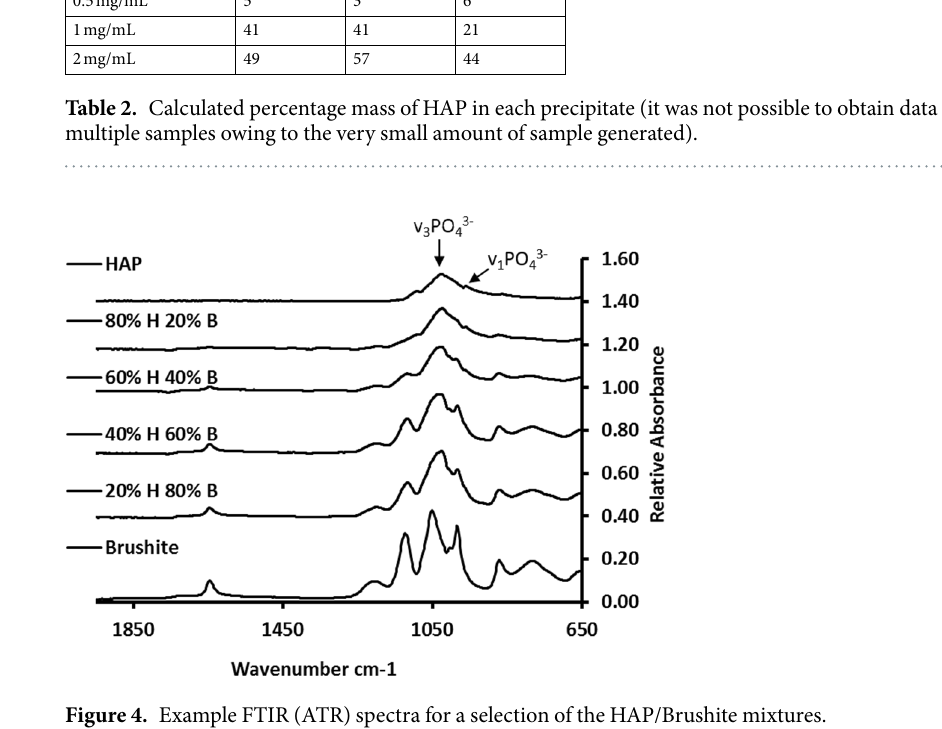
Figure 4. Example FTIR (ATR) spectra for a selection of the HAP/Brushite mixtures.